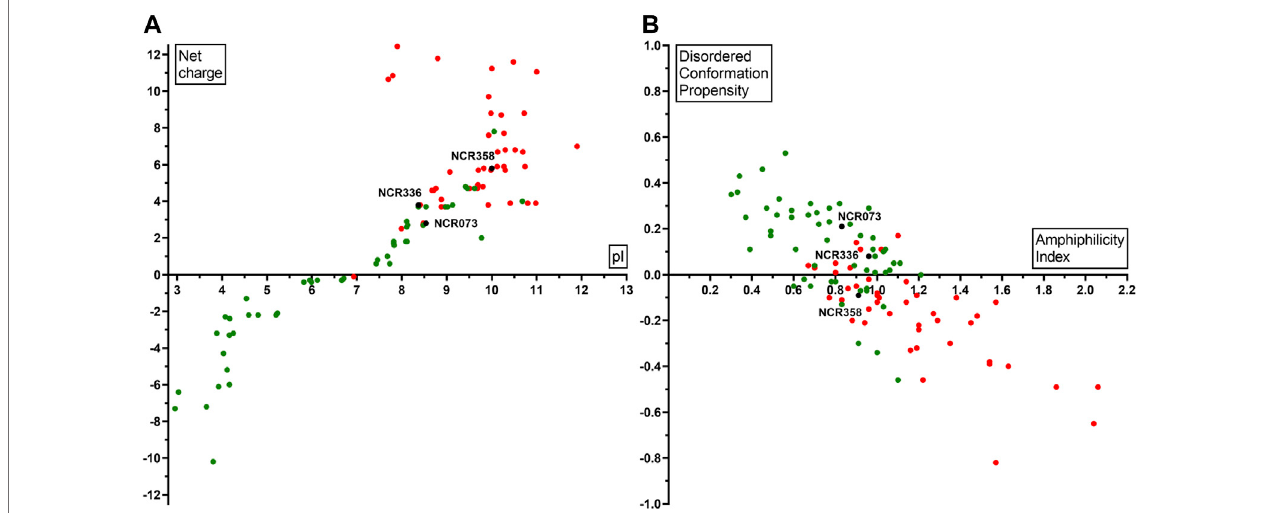
FIGURE 1 | Physicochemical properties of NCRs in correlation with their antimicrobial activity (A) pI ( X axis) and net charge ( Y axis) (B) Amphiphilicity Index ( X axis) and Disordered conformation propensity ( Y axis) in correlation with the antimicrobial activity. Black dots show NCR073, NCR336, NCR358 which are active against all the eight tested pathogens. Red dots represent NCRs which are active against at least one pathogen. Green dots indicate the inactive NCRs.